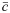
Rating and marking bar charts for Cannock Chase 2012 and Craigvinean 2015/2 as a result of crown thinning experiments.The bars of the rater bar charts were ranked according to rating activity. r–number of raters, n–number of trees, κF–Fleiss’ kappa, rv−coefficient of variation of the proportions of the rater bar chart, c¯–mean conformity number, P0 –proportion of trees marked “0” by all raters, Pm−proportion of trees marked in the 20% highest classes of the marking bar chart, see Section “Statistical measures of interrater agreement”.